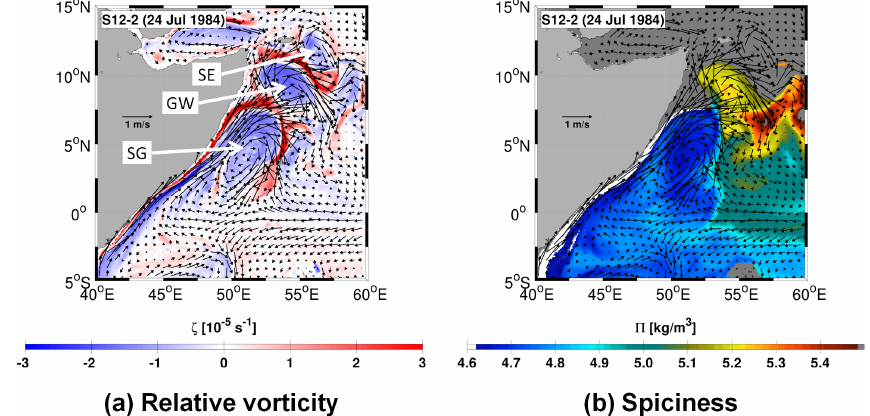
Figure 12. Snapshot on 24 July 1984 of the current (vectors; ms − 1 ) at 50m depth superimposed on (a) relative vorticity ( ζ ; colour shading; s − 1 ) at 50m depth and (b) spiciness on isopycnal σ 0 = 23.8 ( (cid:53) ; colour shading; kgm − 3 ) in the 1 / 12 ◦ S12-2 experiment. SE is Socotra Eddy, GW is Great Whirl, and SG is Southern